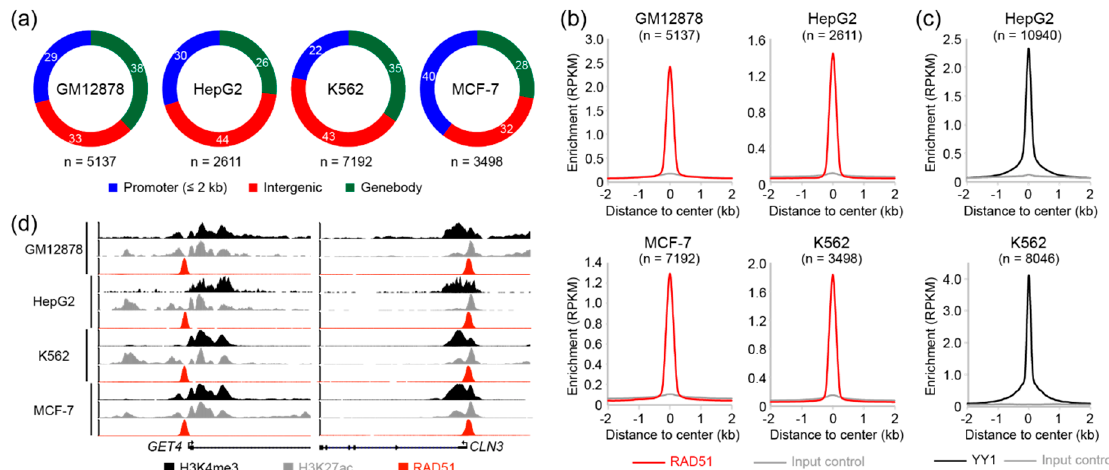
Figure 1. Characteristics of genome-wide RAD51 binding sites. ( a ) Pie charts show the percentage of genome-wide RAD51 binding sites according to gene annotation. Line plots show average enrichment of RAD51 binding at RAD51 binding sites ( b ) and YY1 binding at YY1 binding sites ( c ). ( d ) Enrichment of active (H3K4me3 and H3K27ac) histone modifications around RAD51 binding sites near the GET4 and CLN3 genes is shown.